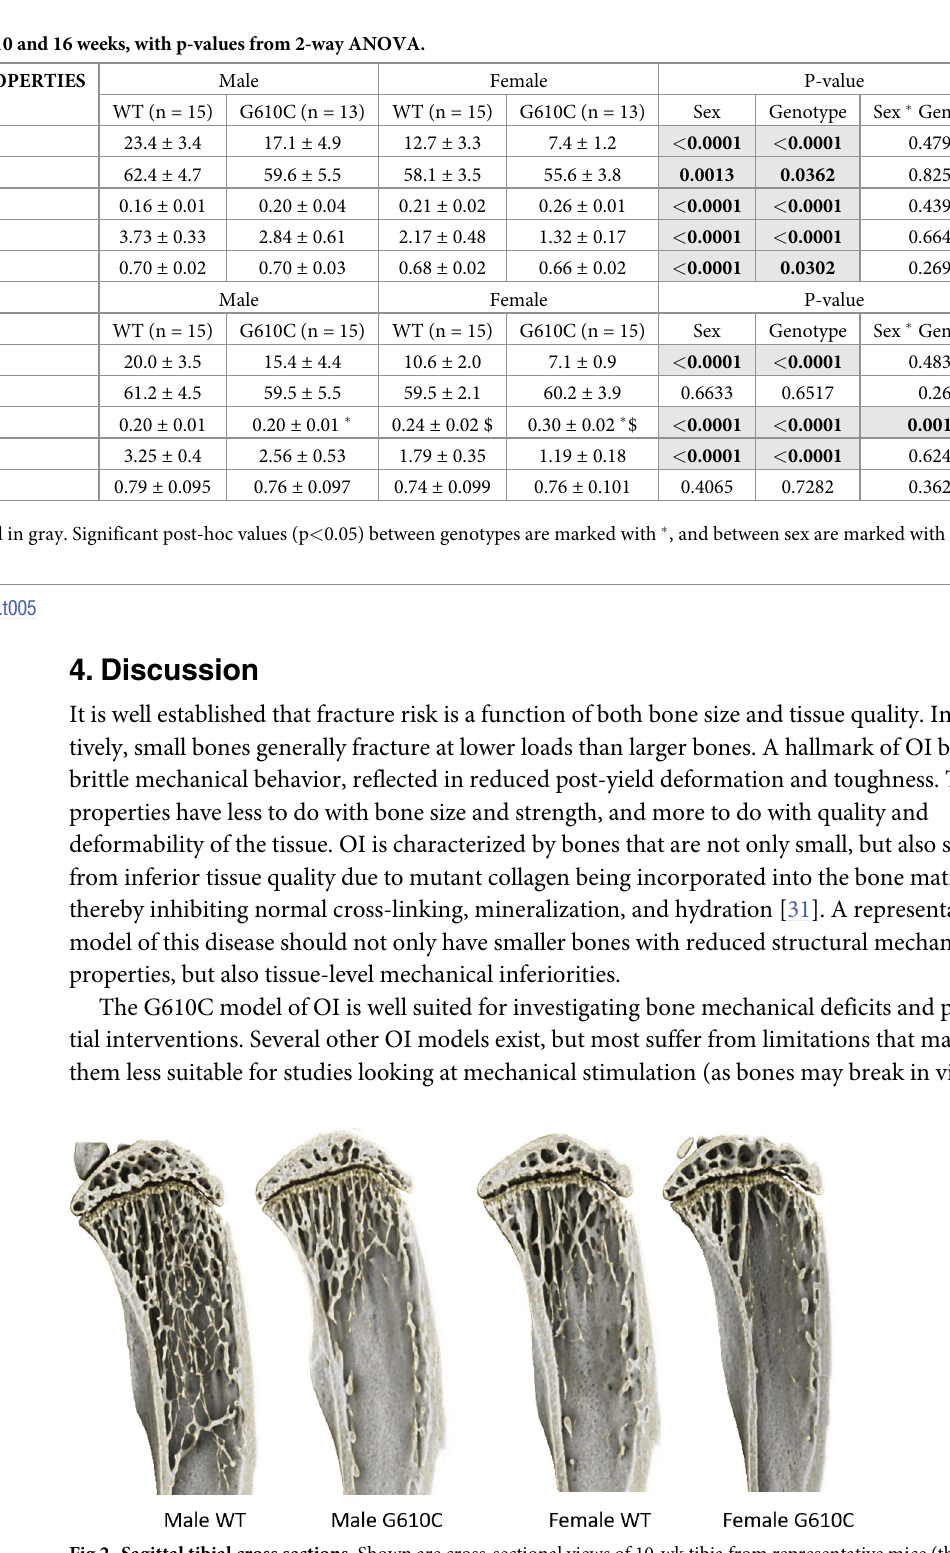
Fig 2. Sagittal tibial cross sections. Shown are cross-sectional views of 10-wk tibia from representative mice (the trend is similar in 16-wk mice). Trabecular bone quantity varies significantly between genotypes.